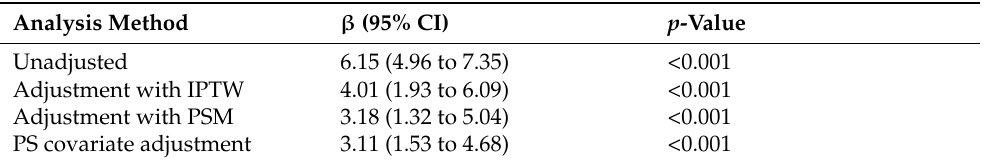
Table 3. Association of intraoperative 20% albumin administration with the duration of postoperative hospitalization (days) before and after